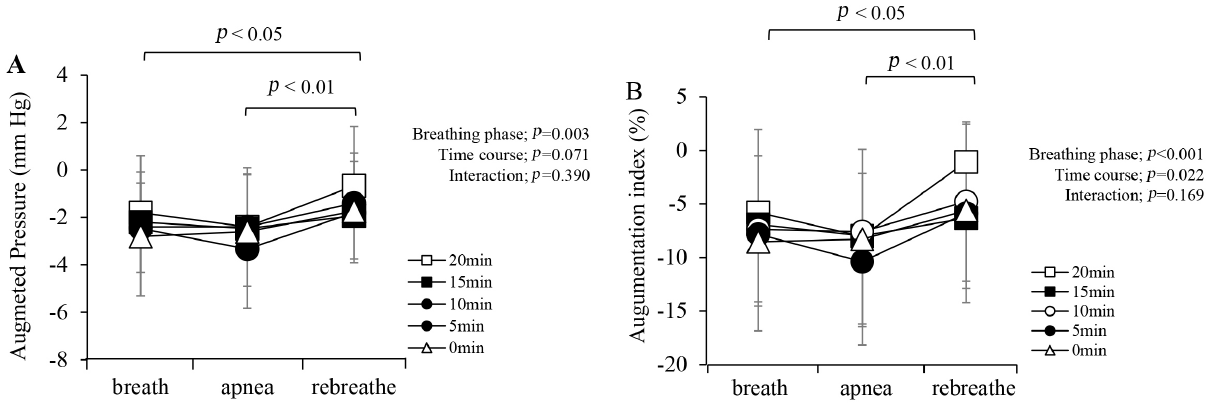
Fig. 3. Response of augmentation pressure (A) and augmentation index (B) at the phase of breath, apnea, and rebreathe during intermittent apnea in 20 min. Symbols represent mean values, and error bars represent standard